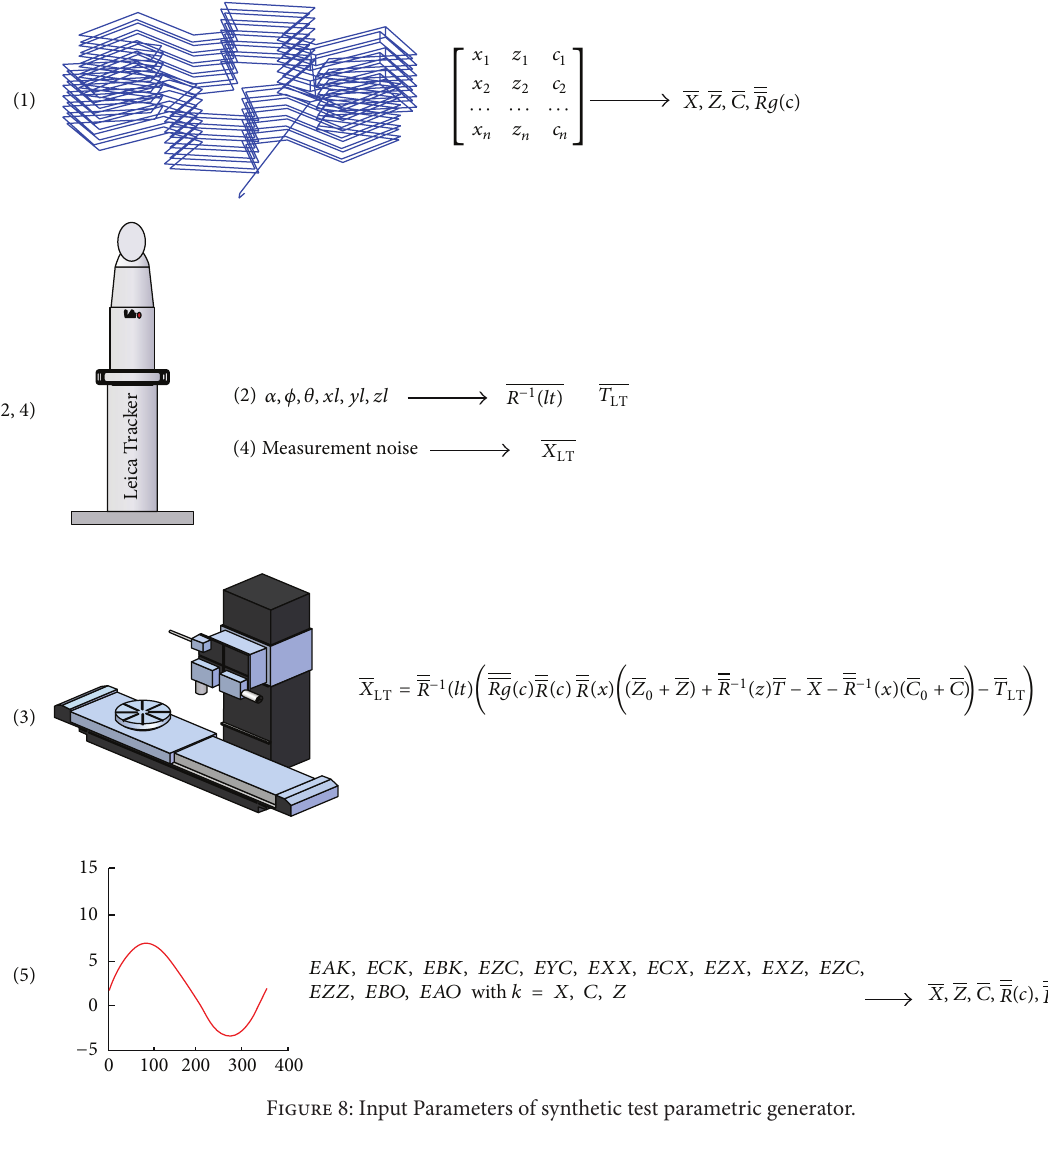
Figure 8: Input Parameters of synthetic test parametric generator.